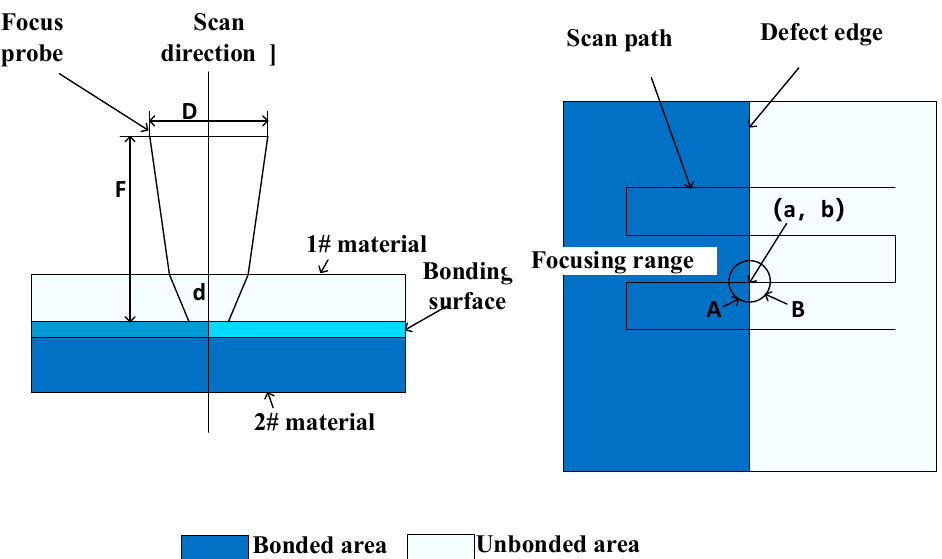
Figure 11. Schematic diagram of ultrasonic C-scan imaging.